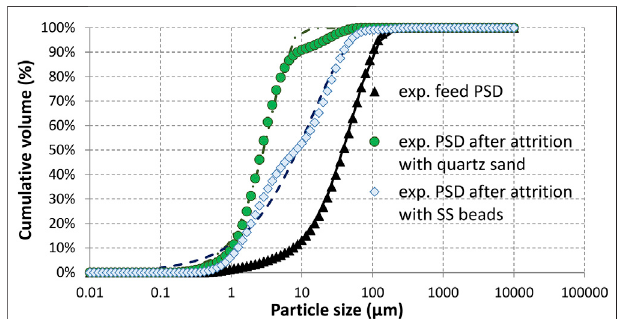
FIGURE 3 | Cumulative particle size distributions measured by laser diffraction (symbols) and corresponding Rosin-Rammler fi t (lines) for feed and product particles after 24 h of attrition-leaching using stainless steel beads and quartz